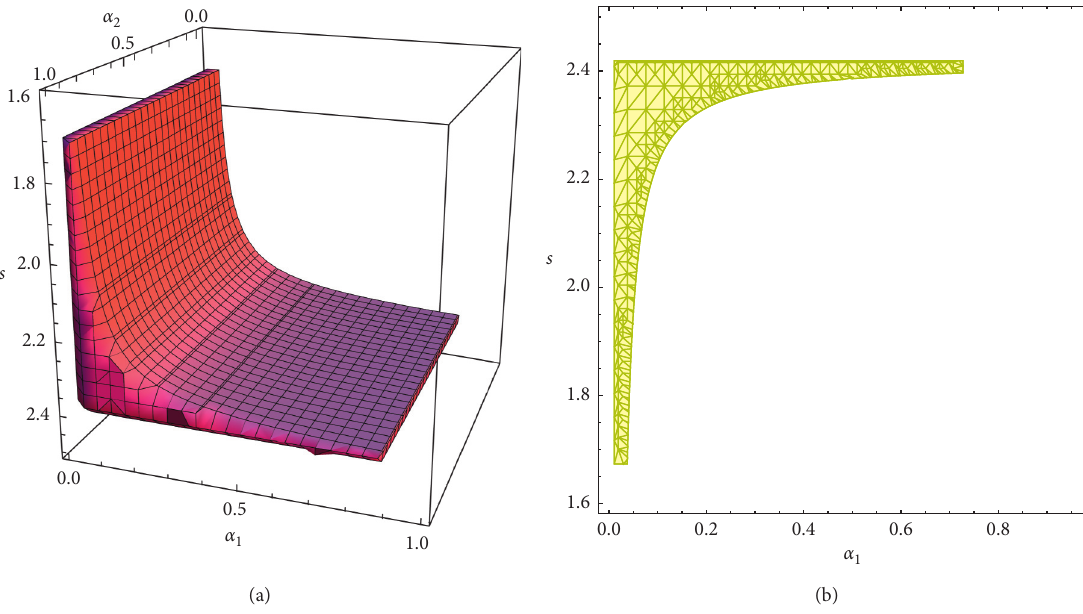
Figure 9: Stable region with respect to α